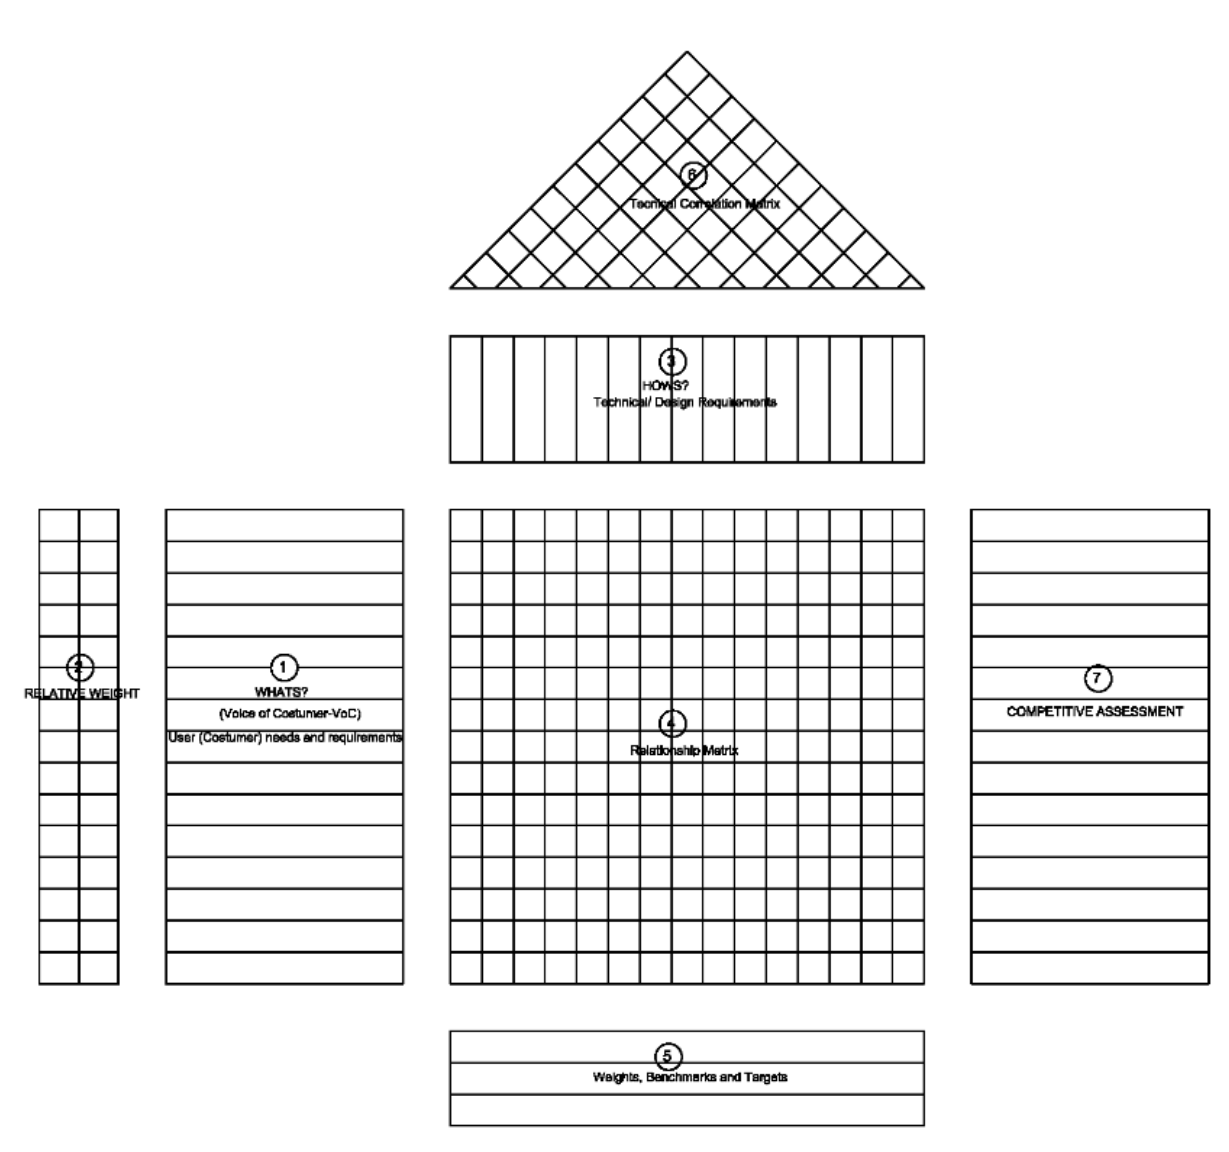
Figure 2. Steps of the house of quality diagram.